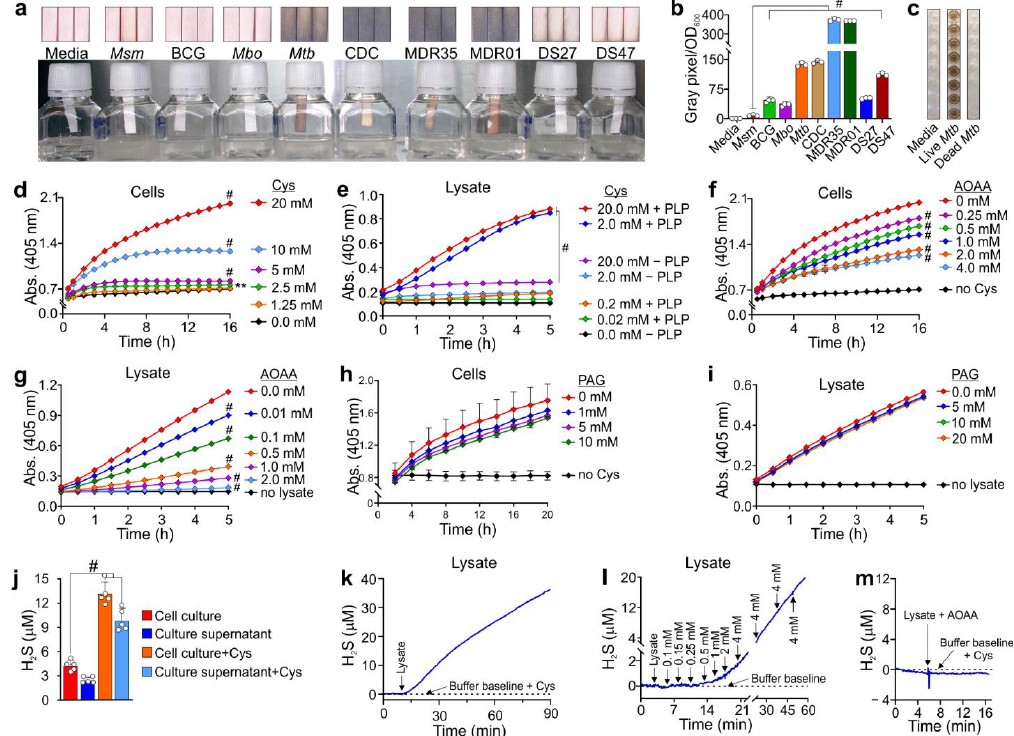
Figure 1. Mycobacterial species produce H 2 S. ( a ) Detection of H 2 S in the headspace of cultures of mycobacterial species using lead acetate strips. Msm : M. smegmatis ; BCG: M. bovis BCG; Mbo : M. bovis ; Mtb : Mtb H37Rv; CDC: Mtb CDC1551; MDR: multi-drug resistant; DS: drug-sensitive clinical strains of Mtb . Note that strips shown, (Figure 1a top insert) were scanned after 48 h of incubation. The inkwell bottles shown are representative of an independent experiment after 72 h of incubation. ( b ) Estimation of H 2 S production by quantifying lead sulfide staining (Figure 1a top insert) using densitometric analysis. Data normalized to the optical density (OD 600 ) of each culture, ( n = 3). ( c ) Microplate-based BC assay showing H 2 S production by live and heat-killed Mtb H37Rv. Time course measurement of H 2 S production using a BC assay for ( d ) intact Mtb H37Rv cells, ( n = 5–8) and ( e ) lysates with different concentrations of Cys, ( n = 3–4). BC assay of ( f ) intact Mtb H37Rv cells ( n = 3–5) and ( g ) Mtb H37Rv lysates in the presence of AOAA showing reduced H 2 S production, ( n = 4). No significant inhibition of H 2 S production for ( h ) intact Mtb H37Rv cells ( n = 3–4) and ( i ) lysates was demonstrated in the presence of PAG, ( n = 4). A Unisense A/S H 2 S microsensor was used to measure the H 2 S concentration in ( j ) Mtb H37Rv cultures and bacteria-free supernatants, ( n = 4). Microsensor measurements of real-time H 2 S production in Mtb H37Rv lysates in assay buffer (0.2 M triethanolamine–HCl, pH 8.0; 10 µ M PLP, 10 mM EDTA) with ( k ) 20 mM L-Cys, ( l ) stepwise addition of L-Cys (arrows indicate the amount of Cys [mM] added at the time point) and ( m ) 20 mM L-Cys followed by the addition of Mtb lysate preincubated with AOAA (4 mM). Representative experiments are shown; each experiment was repeated at least twice. Data represent the mean ± SD from the indicated n (number of replicates per data set) except for ( k – m ) which show representative real-time measurements for one sample with 2–3 independent repeats. All p -values are relative to untreated controls or as indicated. Statistical analyses were performed using GraphPad Prism 8.4.3. One-way ANOVA with Dunnett’s multiple comparisons test was used to determine statistical significance. # p <